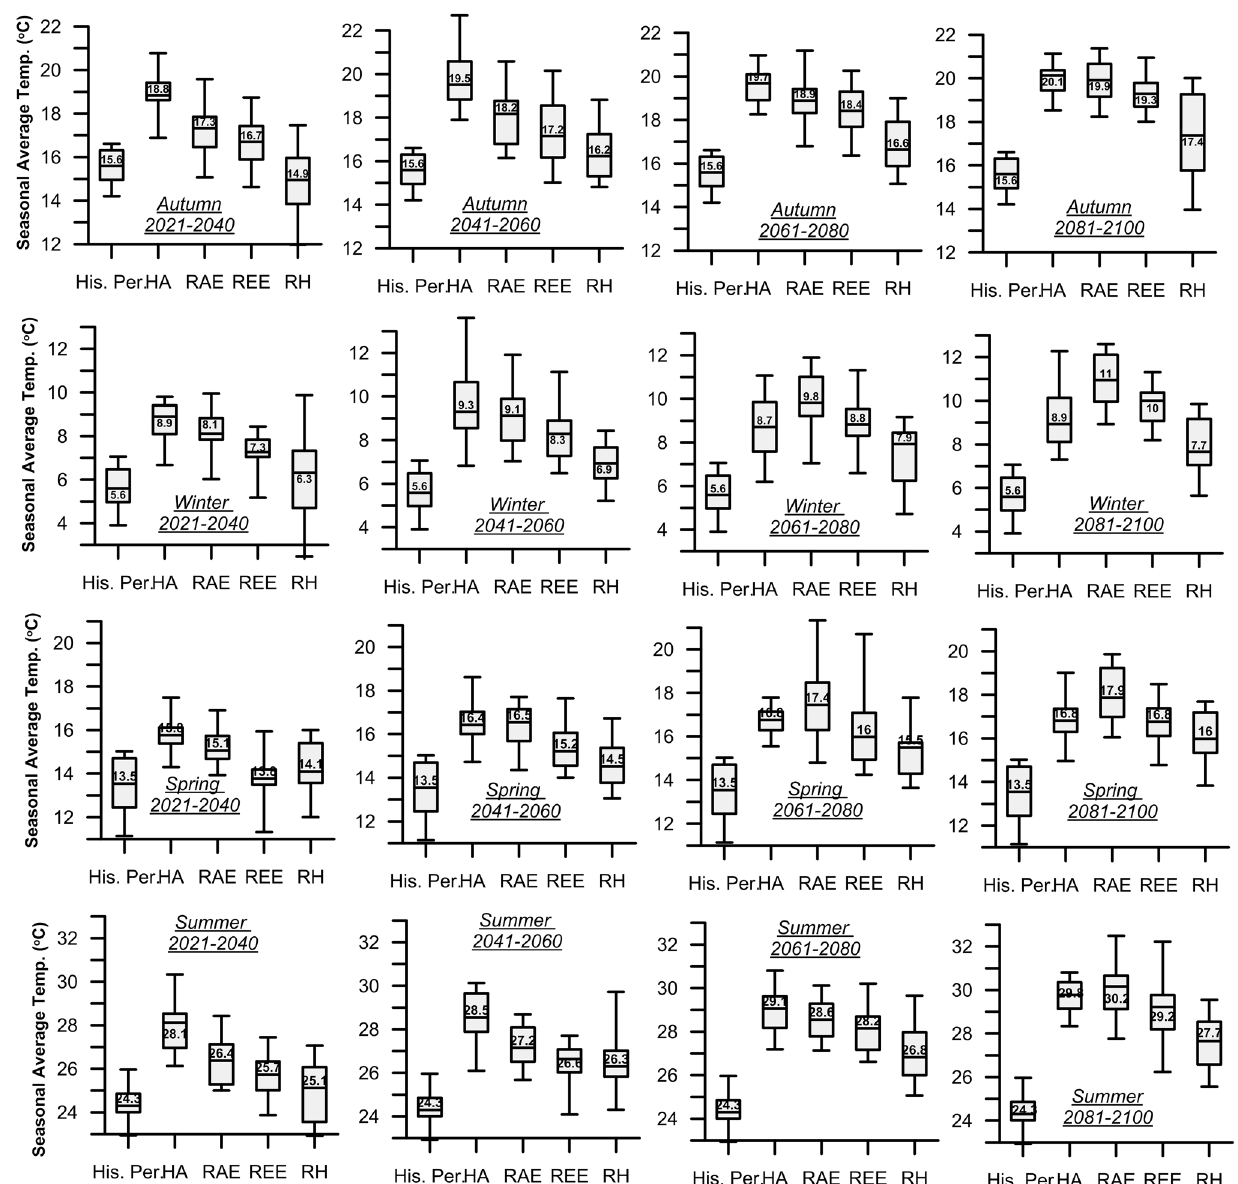
Fig. 10 Box-plots of seasonal average temperature variation according to results from the four RCM–GCM combinations for the periods